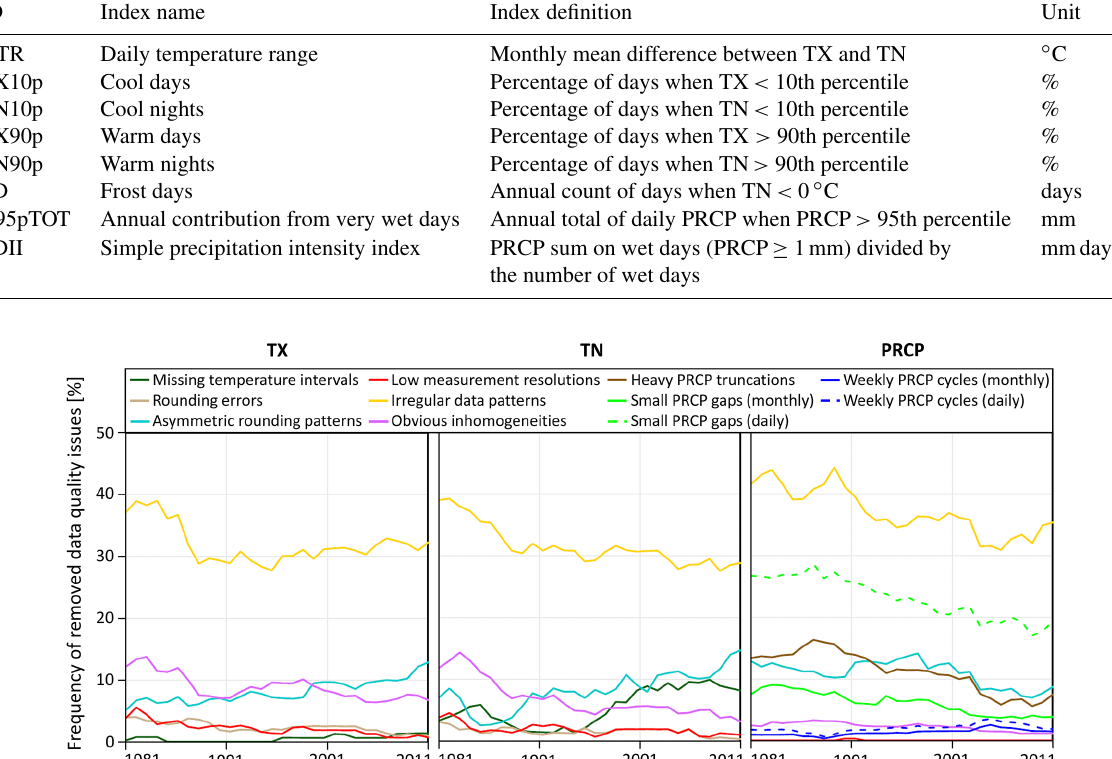
Figure 2. Annual frequency of the data quality issues that cause the exclusion of the affected time series segments for maximum and minimum temperature (TX and TN, respectively) and precipitation (PRCP). If not specified, the frequencies apply to daily observations and monthly aggregations. Note that tests for systematic data quality issues were done in parallel, and time series segments may therefore be affected by several quality issues